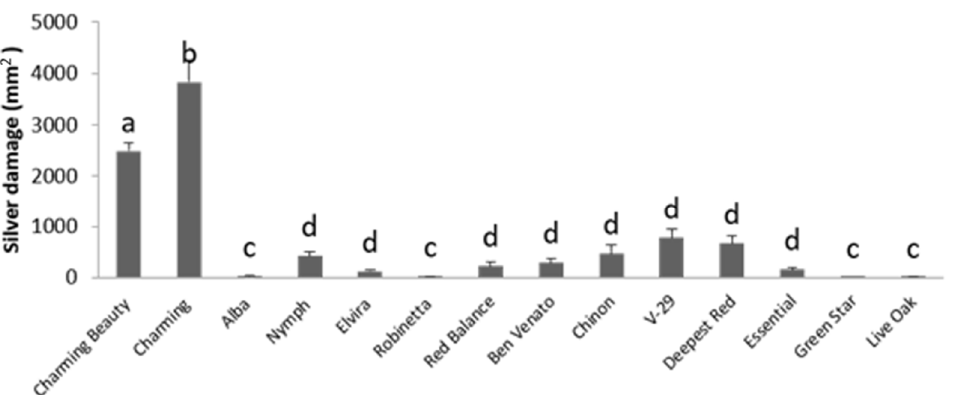
Figure 1. Silver damage (mm 2 ) in 14 Gladiolus varieties, as measured by a whole-plant thrips non-choice bioassay. Data represent means and standard errors for three to five replicates. Different letters indicate significant differences between varieties at p ≤ 0.05.